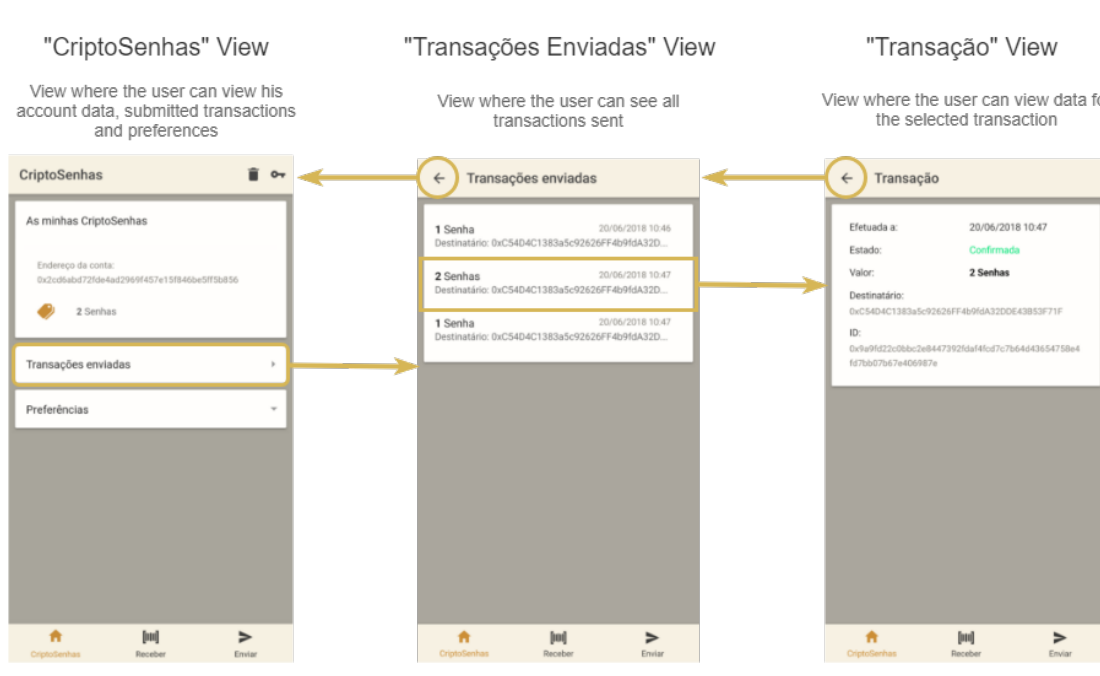
Figure 17. Application Binary Interface (ABI) example of the “transfer” method. Having access to the contract instance, it is possible to invoke the methods of this contract. However, there are two types of distinct operations: (1) transactions that require registration in